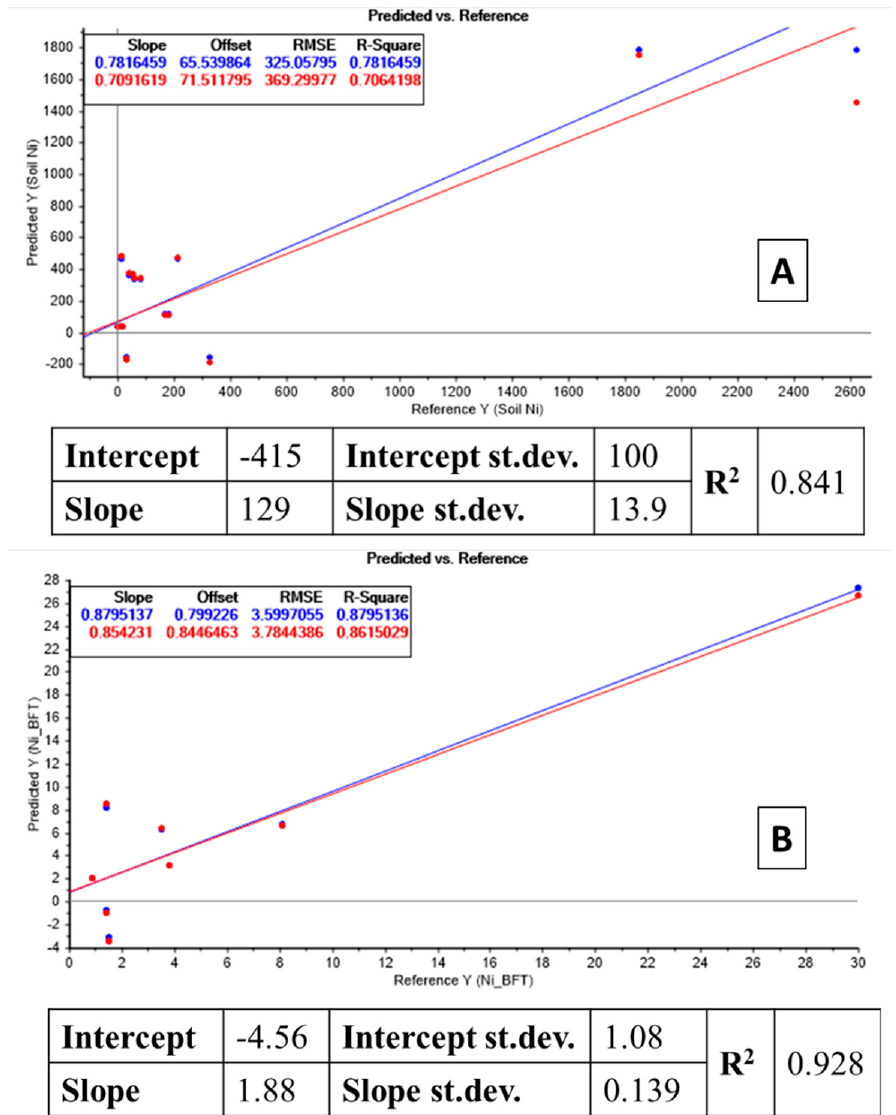
Figure 3. ( A ) Table: Linear regression between total Ni concentration in soil and Ni in P. annua shoots. Plot: recalculated total soil Ni by the model, input data derived from the linear relation between total Ni in soil, and Ni in plant. Blue dots: forecasted soil Ni concentrations in calibration mode (all soil data were used as input). Red dots: forecasted soil Ni concentrations in cross-validation mode, excluding one soil data at a time (leave-one-out mode). ( B ) Table 2: Linear regression between bioavailable Ni concentration in soil and Ni in P. annua shoots. Plot: Recalculated total soil Ni by the model; input data are derived from the linear relation between total Ni in soil and Ni in plant. Blue dots: forecasted soil Ni concentrations in calibration mode (all soil data were used as input). Red dots: forecasted soil Ni concentrations in cross-validation mode, excluding one soil data at a time (leave-one-out mode).